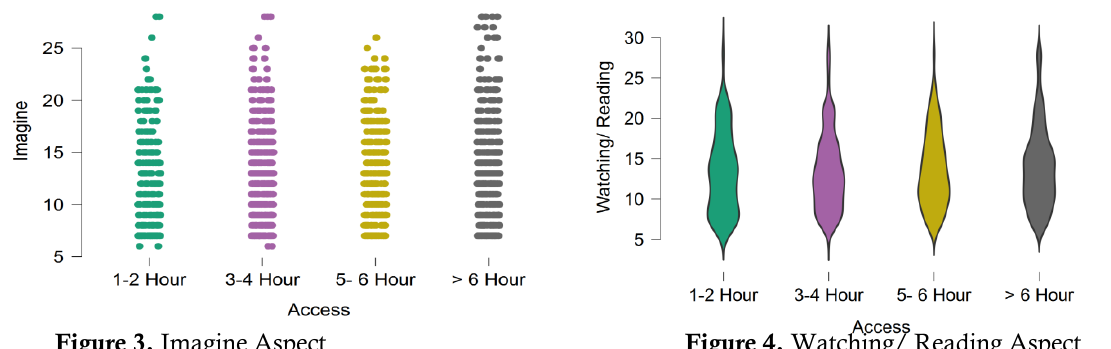
Figure 3. Imagine Aspect Figure 4. Watching/ Reading